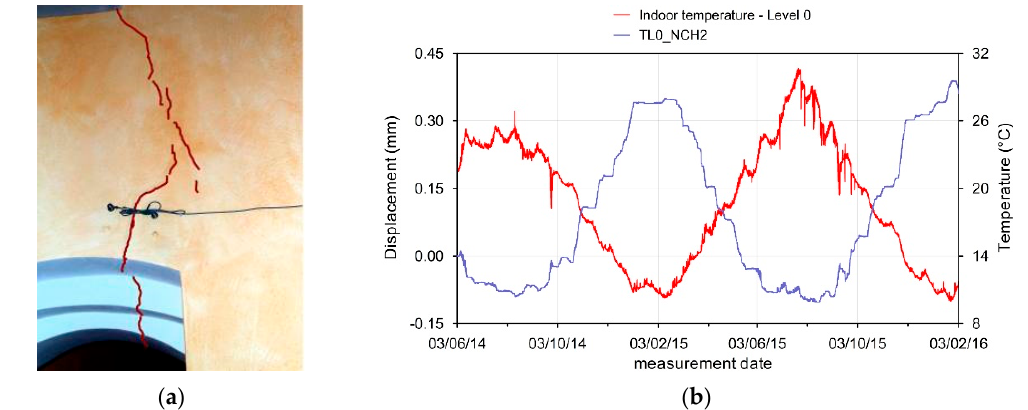
Figure 15. ( a ) Position of the sensor; ( b ) measurements indicating prevalent thermal effects on the crack opening [20].